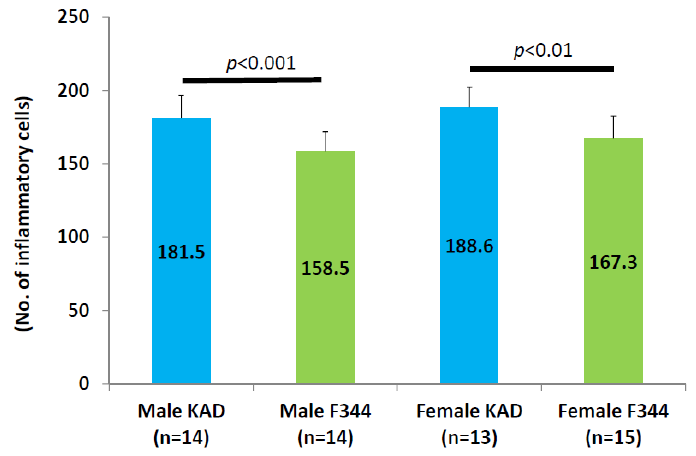
Figure A1. The number of inflammatory cells infiltrating the tongue (per microscopic field at ×400). The values are represented as the means ± SD.